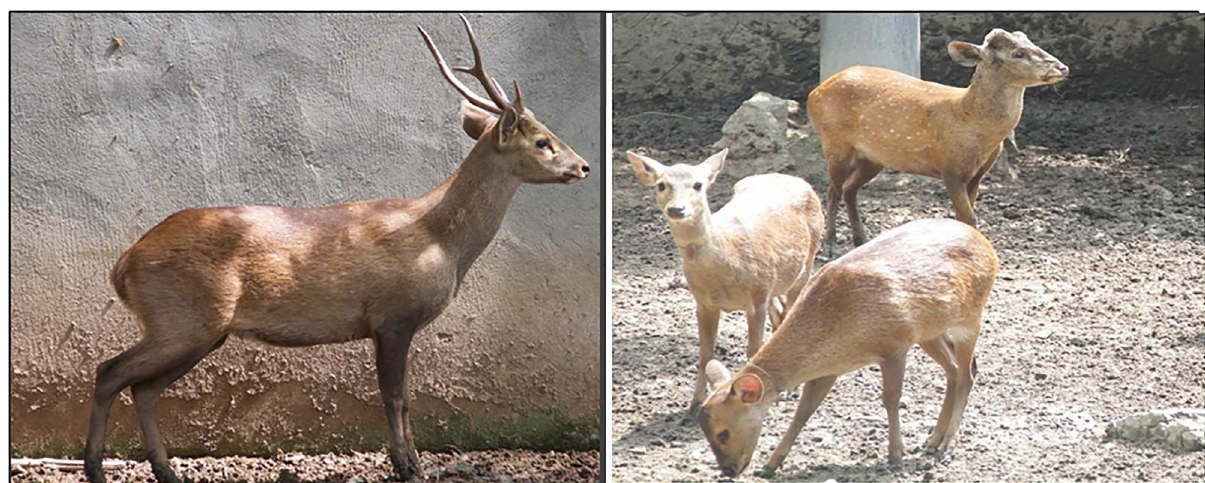
Fig 1. Photos of a male hog deer, approximately five years old (left), and three related individuals (right) reared in Chengdu